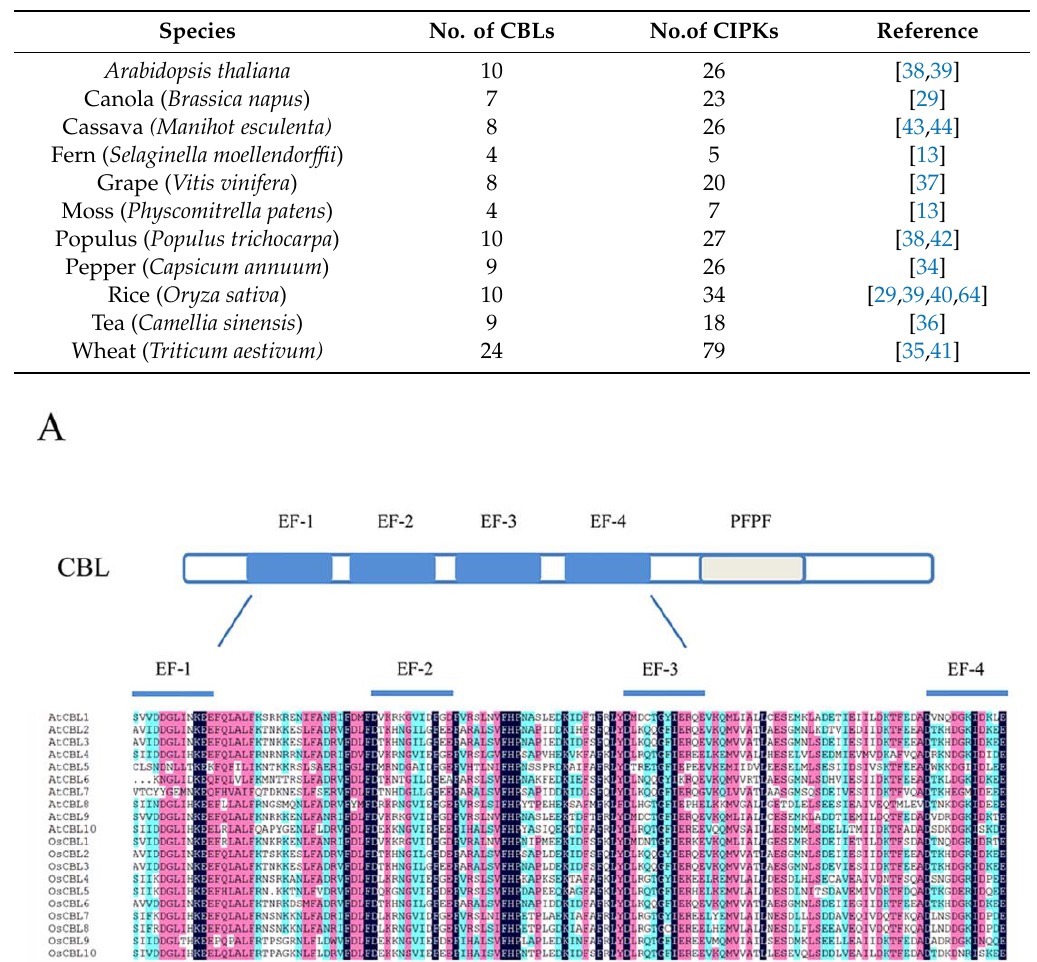
Table 1. The CBL and CIPK families in plant